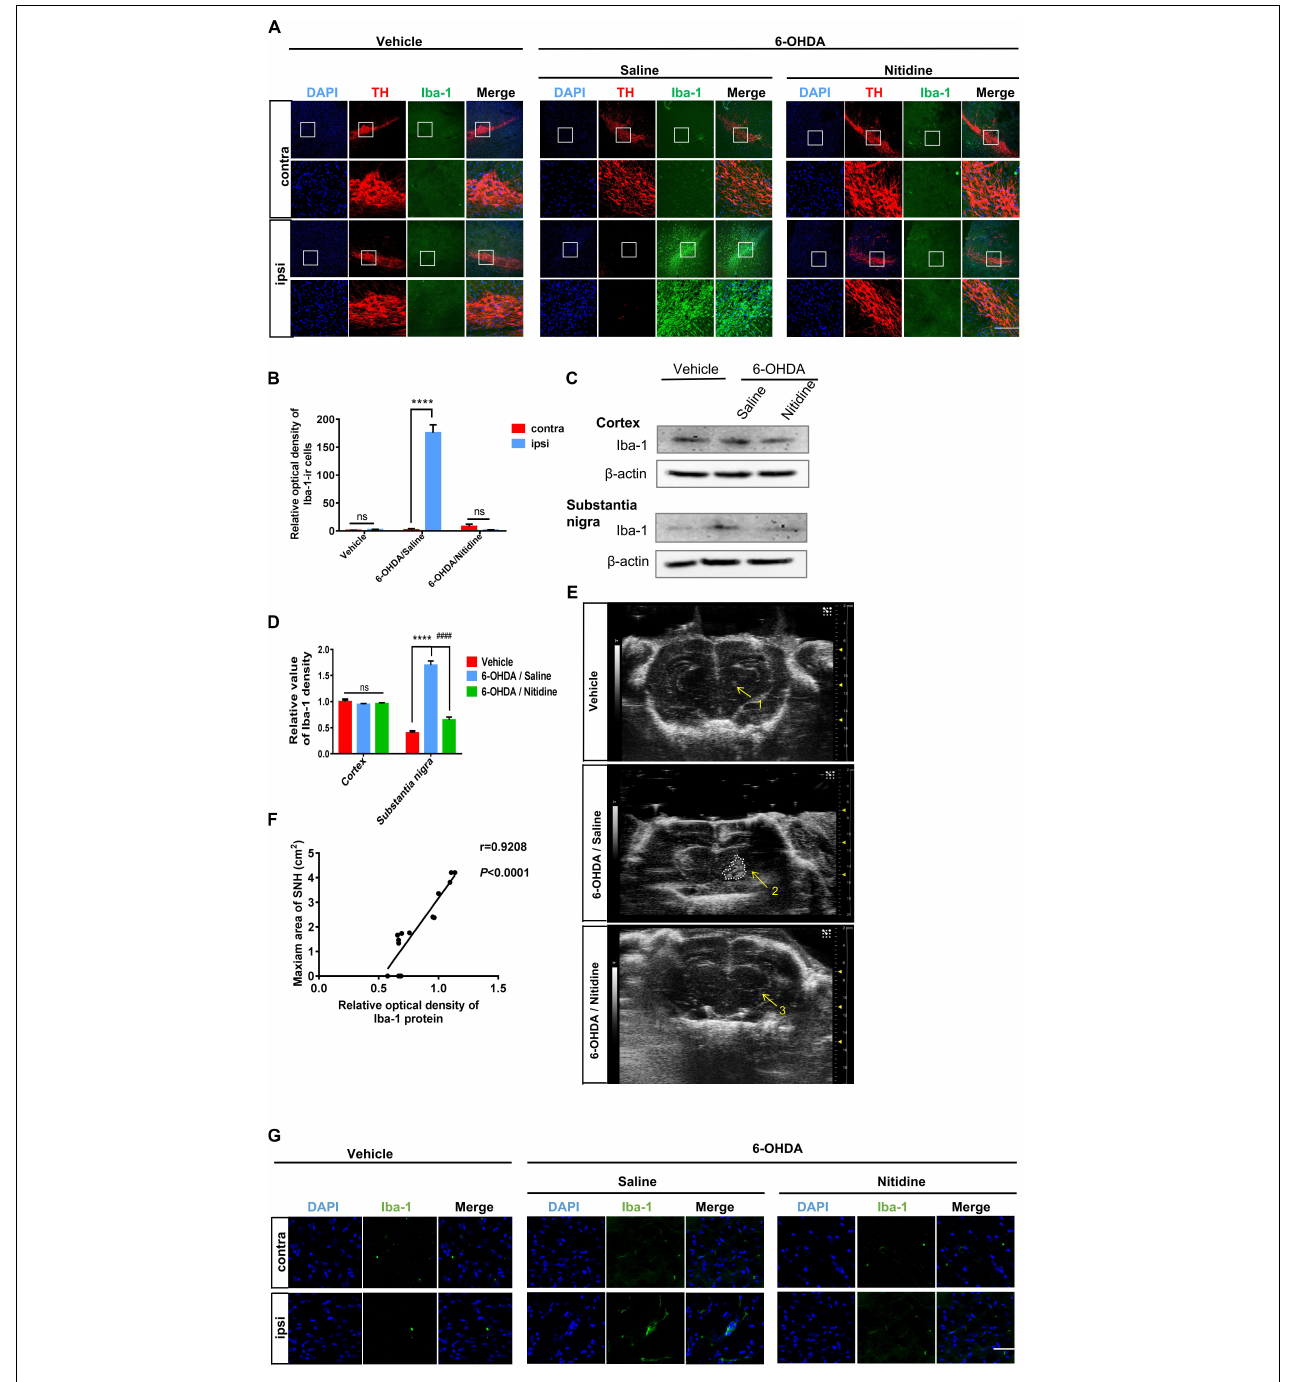
FIGURE 5 | Reactive microgliosis in the substantia nigra (SN) of 6-hydroxydopamine (6-OHDA)-induced Parkinson’s disease rats with or without nitidine treatment. (A) Double immunofluorescence of the activated microglia marker Iba-1 (green) and tyrosine hydroxylase-immunoreactive dopaminergic neurons (red). Scale bar depicts 500 µ m. (B) Statistical result of the optical density values of Iba-1-ir cells. Vehicle group: t -test. P = 0.0589, t = 2.618 df = 4, F = 4.355. 6-OHDA/saline group: t -test. P < 0.0001, t = 20.99, df = 4, F = 52.36. 6-OHDA/nitidine: t -test. P = 0.0554, t = 2.678, df = 4, F = 86.41. (C) Iba-1 protein expression revealed by Western blot. (D) Histogram showing that the level of Iba-1 protein was significantly decreased in the SN of the nitidine-treated group. One-way ANOVA. Cortex: P = 0.4348, F = 0.96. Substantia nigra: P < 0.0001, F = 141.8. (E) Transcranial sonography (TCS) images and substantia nigra hyperechogenicity (SNH) qualification after nitidine or saline treatment. Only a scatter echo matching the shape of the needle emerged in the vehicle group (1); the nitidine-treated group did not show visible SNH (3), while the saline-treated group showed a significant SNH (2). Area 2 = 1.111 cm 2 . (F) Correlation analysis between Iba-1 protein expression and maximum SNH area under TCS. P < 0.0001, r = 0.9208, R 2 = 0.848, F = 66.93. (G) Morphological changes of Iba-1-ir microglia under × 80 lens. Scale bar depicts 3 cm. *Comparison between contralateral and ipsilateral from a single group. # Comparison between different groups. ns P > 0.05, # P < 0.05, #### P < 0.0001, ** P < 0.01, *** P < 0.001, **** P < 0.0001.